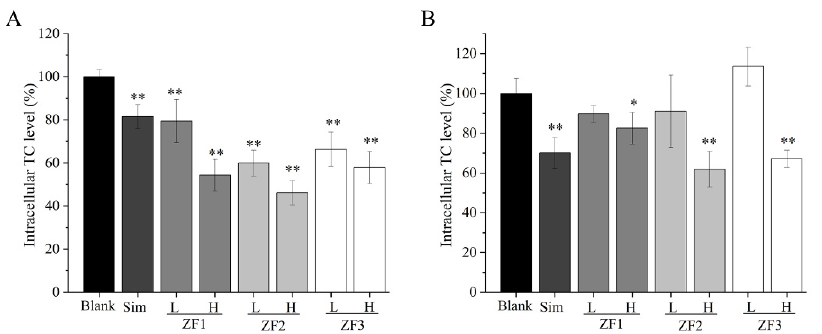
Figure 7. The effects of low and high concentrations of ZF1, ZF2, and ZF3 on intracellular TC content at 24 h and 48 h. ( A ) The effects of low and high concentrations of ZF1, ZF2, and ZF3 on intracellular TC content at 24 h; ( B ) the effects of low and high concentrations of ZF1, ZF2, and ZF3 on intracellular TC content at 48 h. The cells in blank group were cultured in DMEM medium without fucoidan. The L refers to a low concentration (200 µ g/mL) of fucoidan, and H means a high concentration (800 µ g/mL) of fucoidan. Compared to blank, * indicates p < 0.05, and ** indicates p <